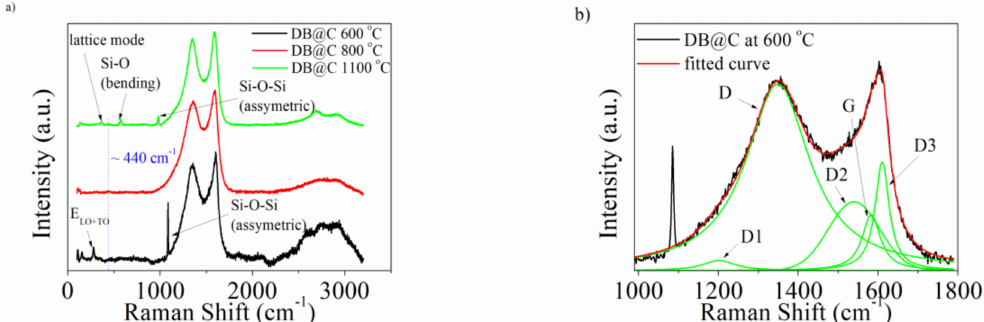
Figure 6. ( a ) Raman spectra for DB@C electrode materials and ( b ) the curve fit for first-order Raman spectra of DB@C at 600 ◦